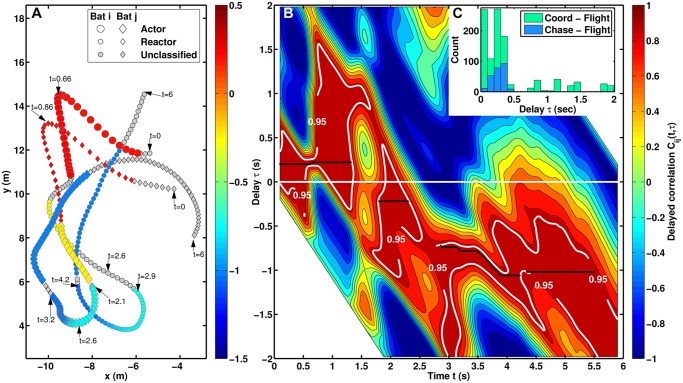
Sample spatio-temporal paired trajectory with the corresponding TDDC function, and observed delay values.(A) Example of a paired flight trajectory subsampled for clarity with every other data point from the original 20 ms resolution. Non-grey symbols show interacting flight segments classified as either chase or coordinated flight extracted (see Methods) from the analysis of the TDDC plot, shown in panel (B), and the TDDS plot (not shown). For a given time and delay the TDDC plot shows the correlation between the headings of the two bats (1 is perfect alignment, 0 occurs when the relative headings is ±90°, -1 represents opposite alignments). Regions of the TTDC plot inside the area demarcated by the 0.95 correlation threshold correspond to relative heading values smaller than 18.2° in magnitude. The colour-coding of the movement paths is obtained from the coordinates (t, τ) of the disjoint black lines (time-ordered procedure) in panel (b), which assign delay response values between the bats at each instant in time. When no black line is present in the TDDC plot, the behaviour is deemed unclassified and the corresponding movement path in panel (a) is drawn grey. Panel (C) displays the observed delay values of coordinated and chase flights from all recorded trajectories through the analysis of the corresponding TDDS and TDDC plots.